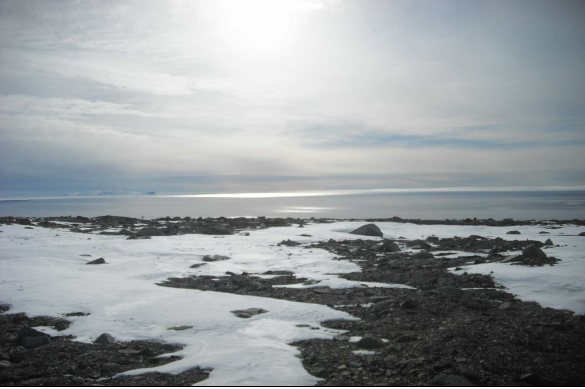
Figure 2. Boulder Clay moraine